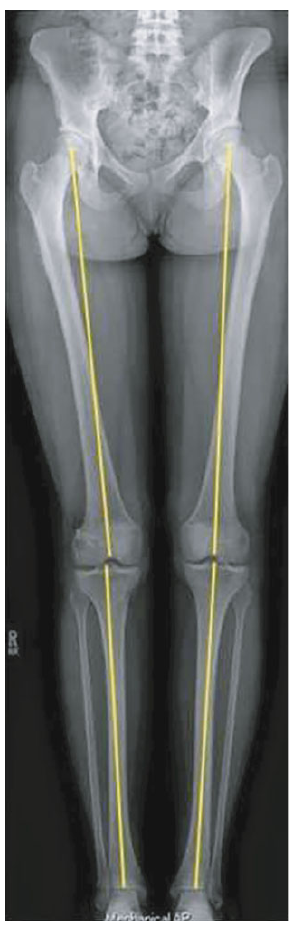
Figure 8: Standing mechanical axis anterior-posterior radiograph at 3 years